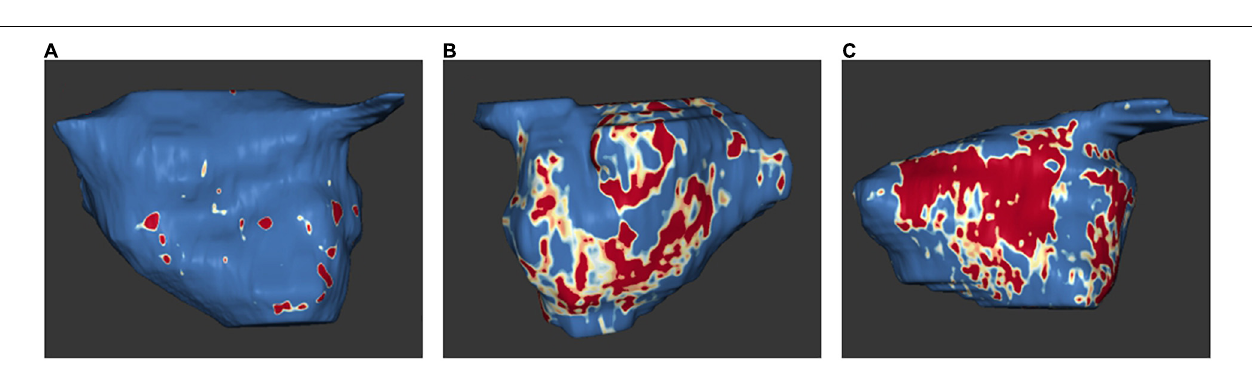
FIGURE 4 | Findings on transesophageal examination suggestive of left atrial cardiomyopathy. (A) Reduced blood flow in the ostium of the left atrial appendage. (B) Evidence of spontaneous echo contrast in the left atrial appendage. (C) Evidence of thrombus in the left atrial appendage.